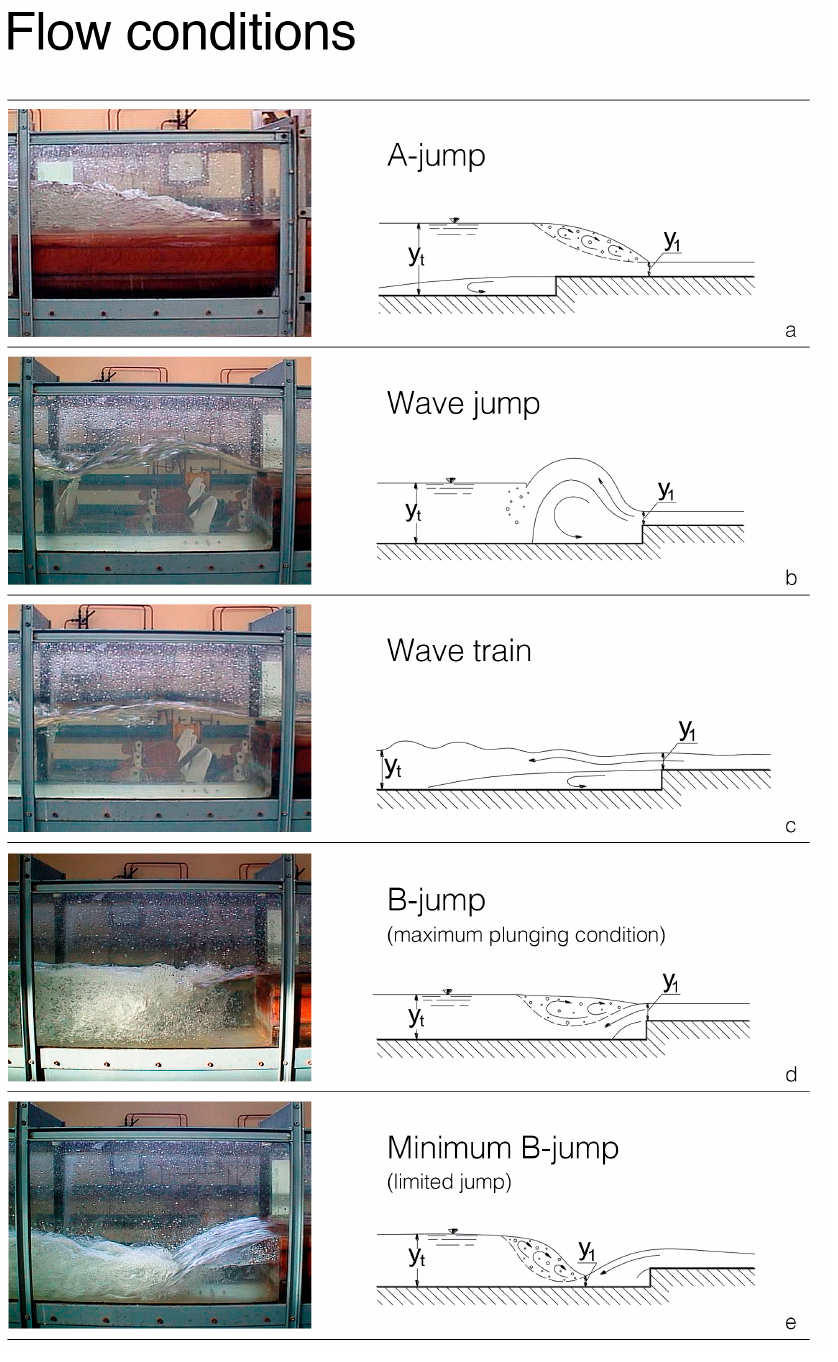
Figure 4. Flow conditions during experiments by Mossa et al. [50]. From the top: ( a ) A-jump; ( b ) wave jump; ( c ) wave train; ( d ) B-jump (maximum plunging condition); ( e ) minimum B-jump (limited jump).